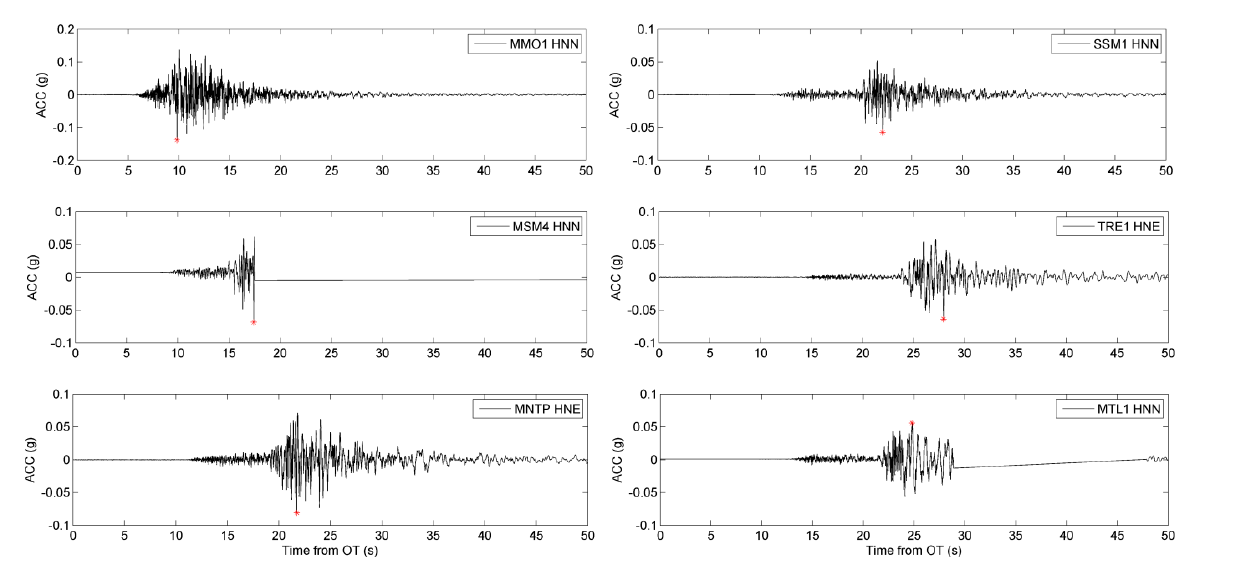
Figure 2. Waveforms with greatest acceleration